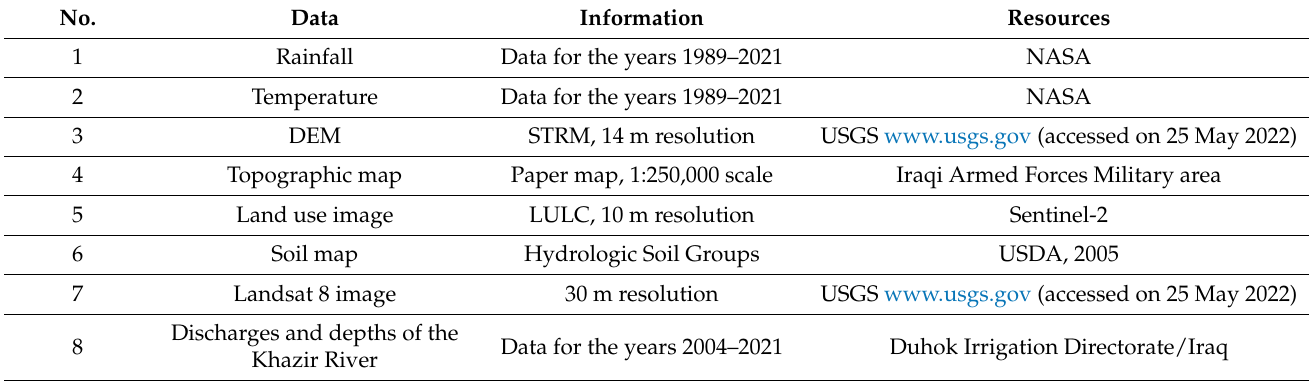
Table 1. Information and data collected about the Khazir River